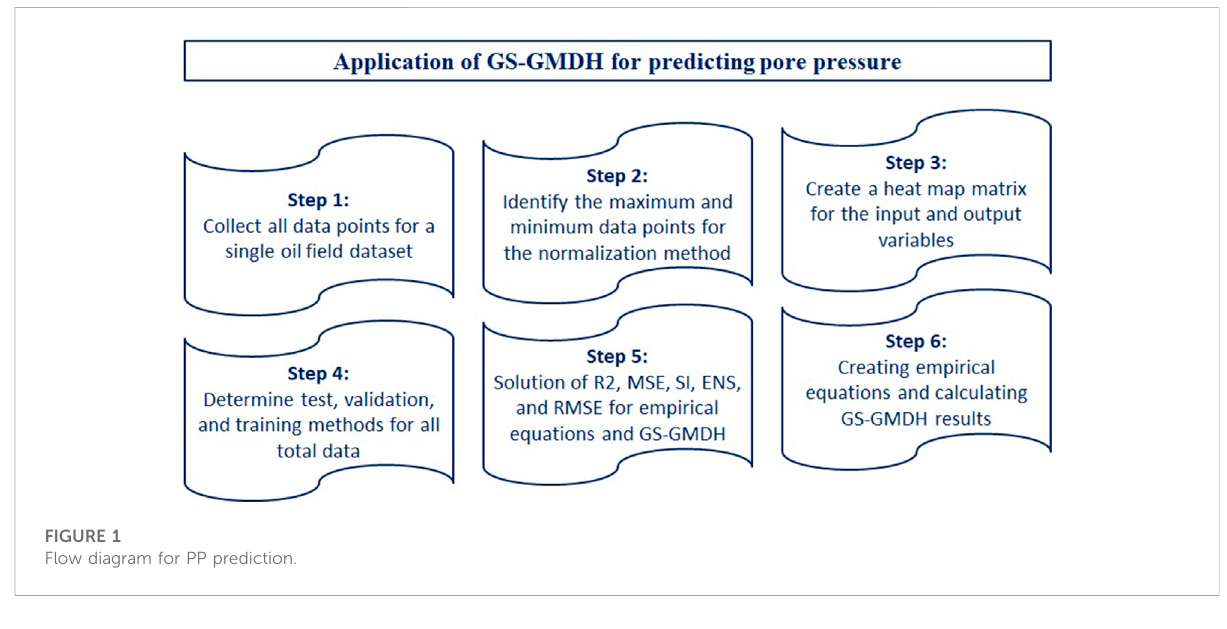
FIGURE 1 Flow diagram for PP